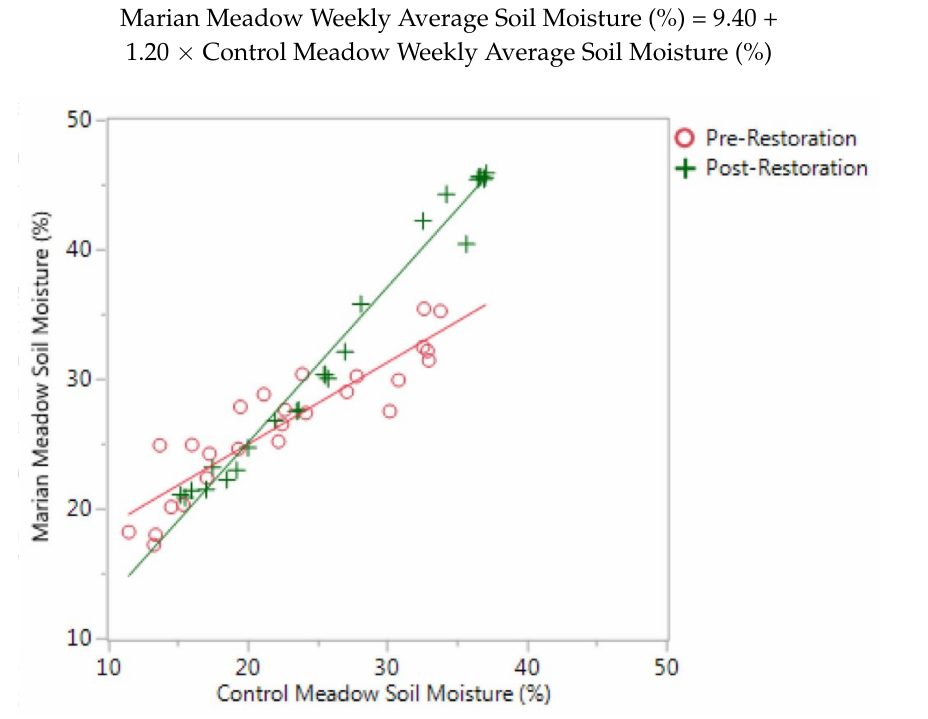
Figure 5. Regression analysis for the Control Meadow and Marian Meadow for pre- and post-restoration soil moisture percentage. Regression analysis based on average weekly measured soil moisture with a lag of three weeks between data points to avoid serial